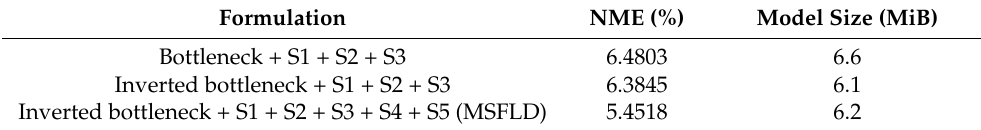
Table 2. Effectiveness of using different configuration in the MSFLD model on the HNUFDD dataset.